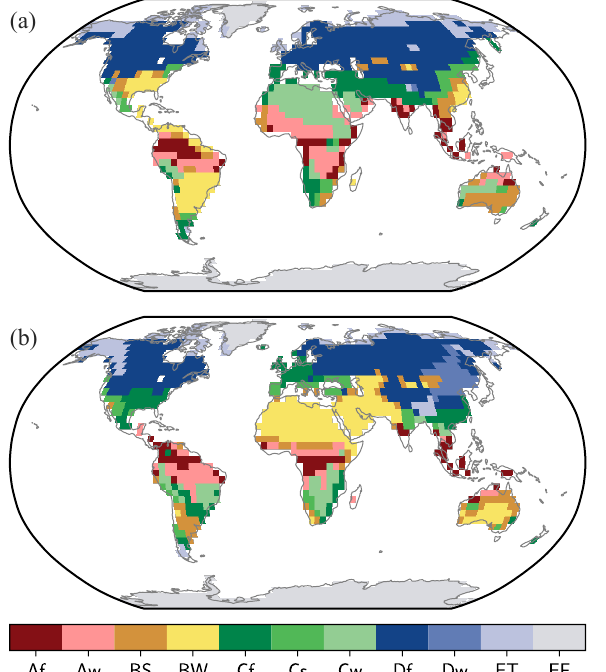
Figure 10. The 11 main climate zones after the Köppen–Geiger classification (colors) for (a) RETRO and (b) CNTRL. First let-